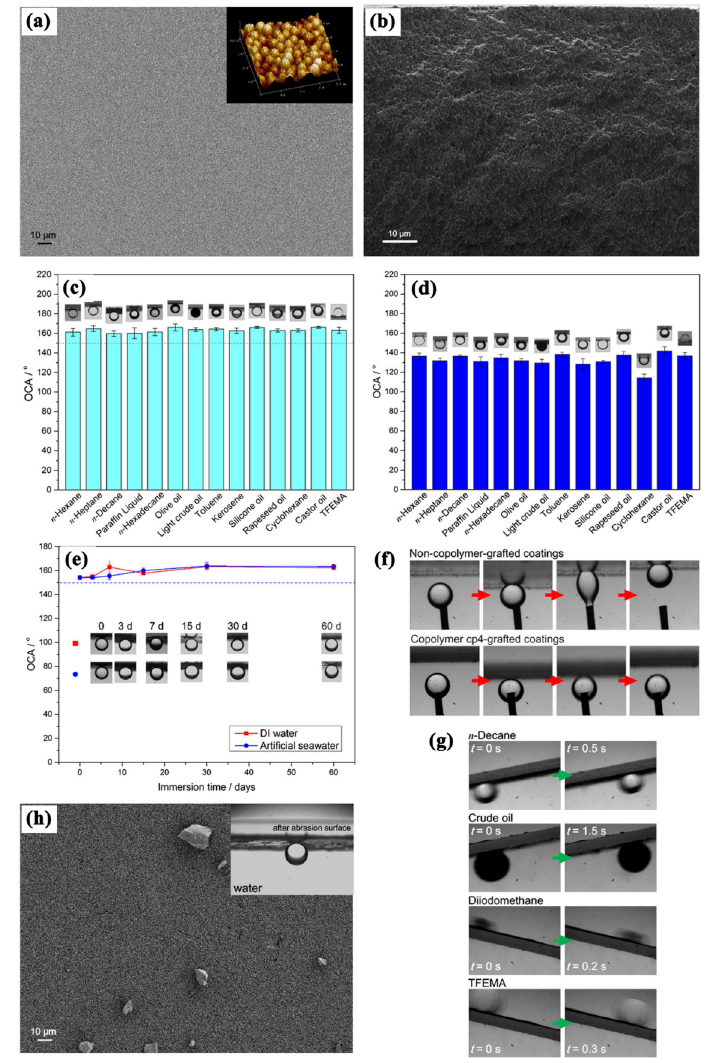
Figure 14. ( a ) FESEM and AFM images of the surface of copolymer-grafted hybrid sphere-based coating. ( b ) Cross-sectional FESEM images of copolymer-grafted hybrid sphere-based coating. ( c ) Underwater OCAs of the typical copolymer-grafted hybrid sphere–based coating. ( d ) Underwater OCAs of pure hybrid sphere-based coating. ( e ) OCAs of coating immersed in DI water and artificial seawater for different days. ( f ) Oil adhesion on coatings. ( g ) Oil droplets rolling on the surfaces of coating. ( h ) Surface morphology and OCA of typical copolymer–grafted hybrid sphere–based coating after sand abrasion test. Reproduced from [77] with permission from the Elsevier